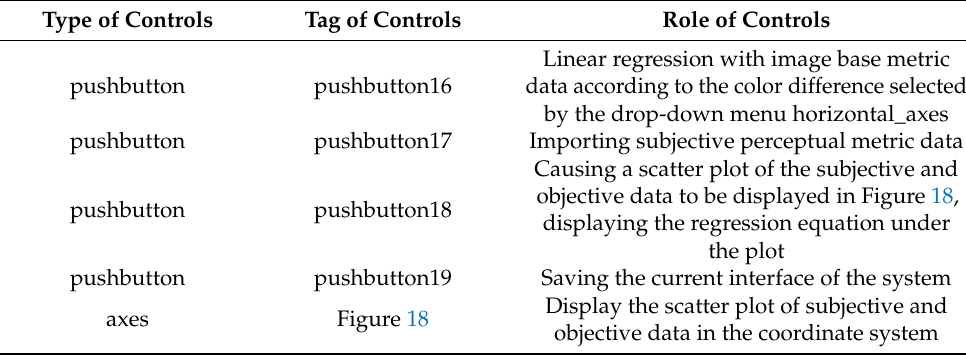
Display the scatter plot of subjective and Figure 18 objective data in the coordinate